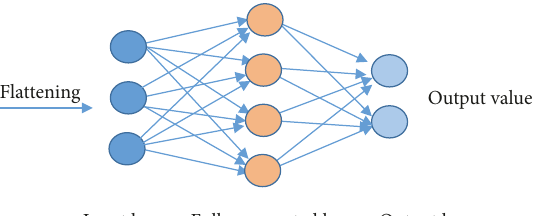
Figure 9: Fully connected